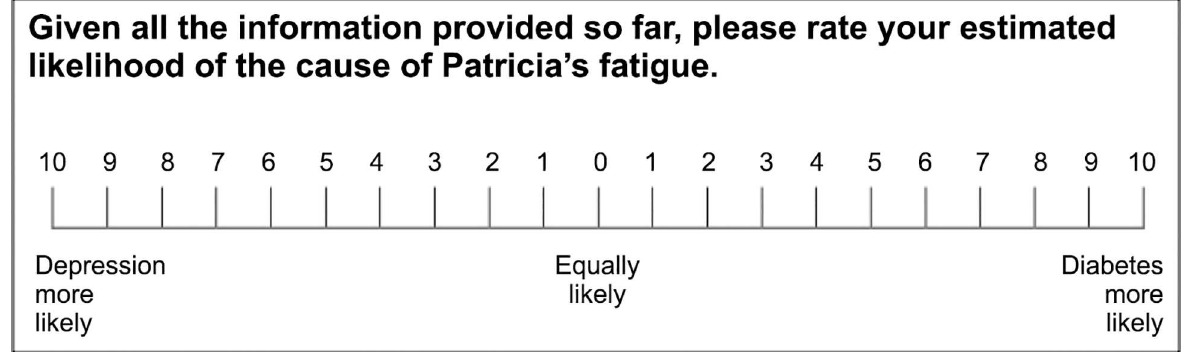
Fig 1. Scale used to estimatediagnostic likelihoodafter1) the steerand 2) each cue evaluation. The same scale was used by Kostopoulou et al. [15] and Nurek et al. [21].